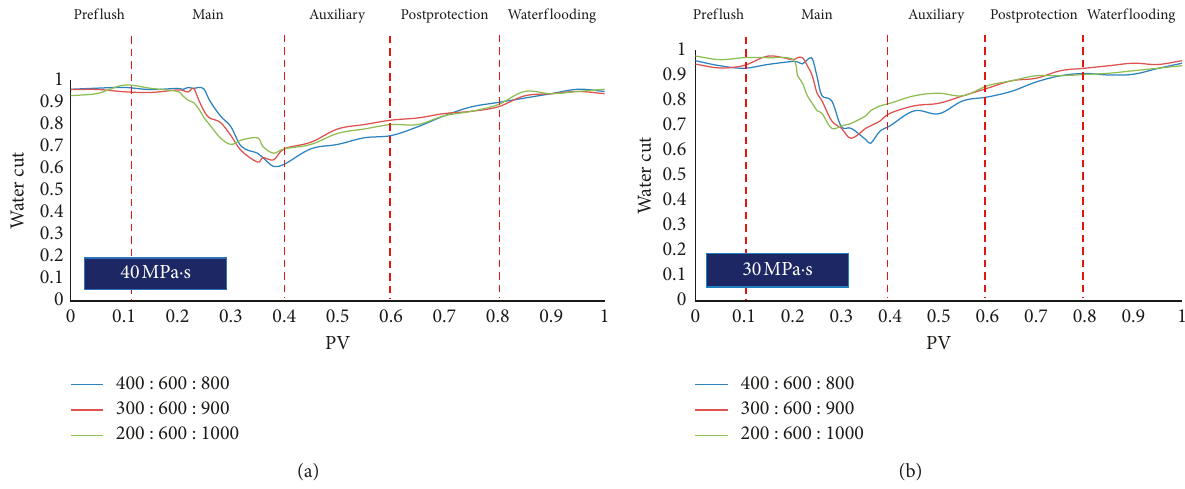
Figure 10: Water cut curve comparison. (a) Water cut with viscosity of 40MPa · s. (b) Water cut with viscosity of 30MPa ·